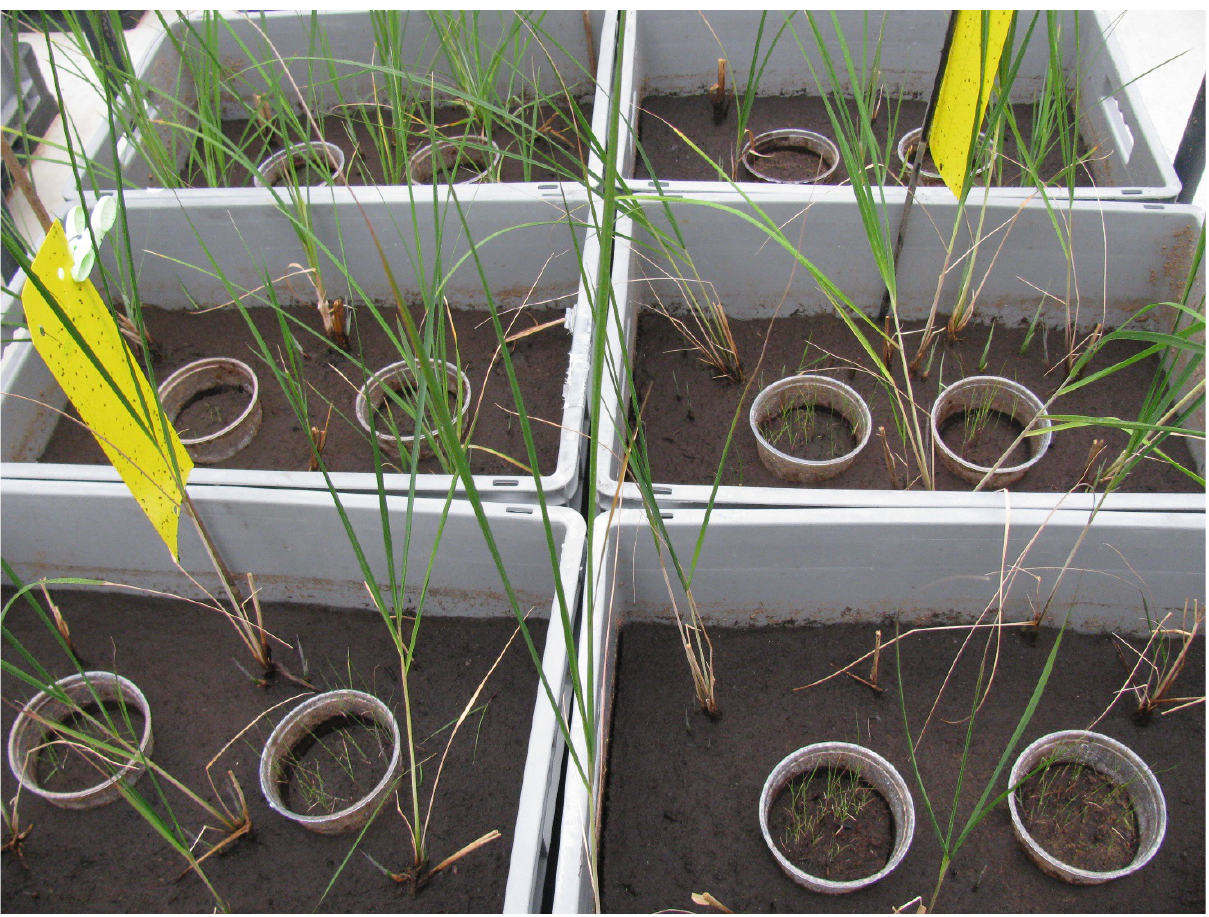
Figure 2. Photograph of one of the five blocks of the greenhouse experiment, comprising six experimental units. Each batch of 50 seeds is surrounded by a plastic mesh